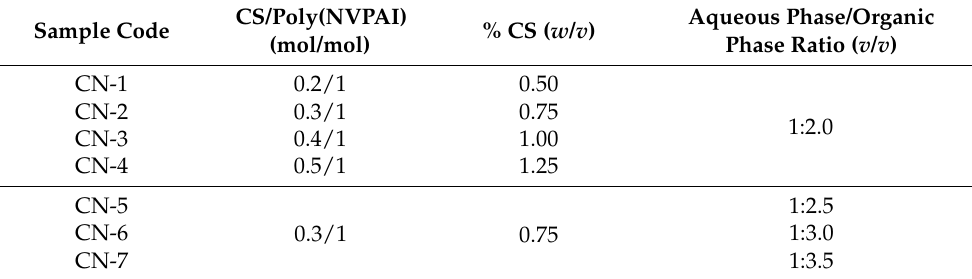
Table 1. Experimental parameters used for the preparation of